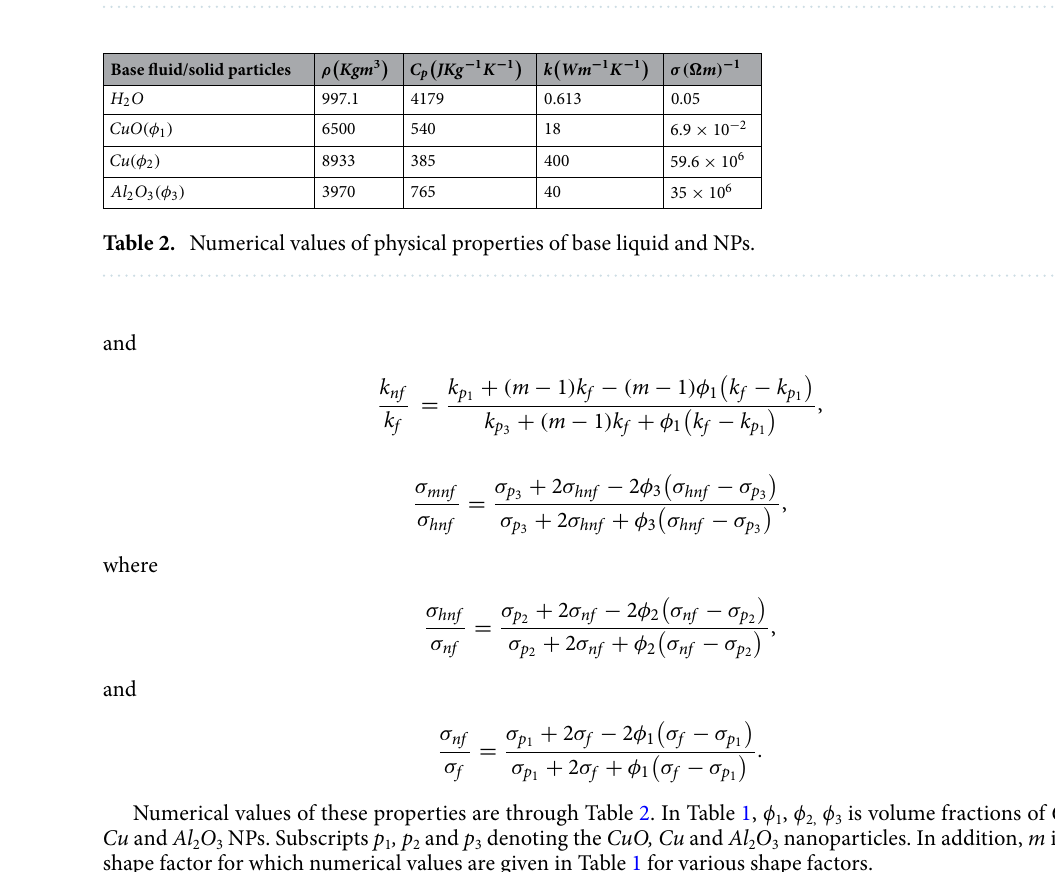
Table 1. The shape factor for several types of NPs.